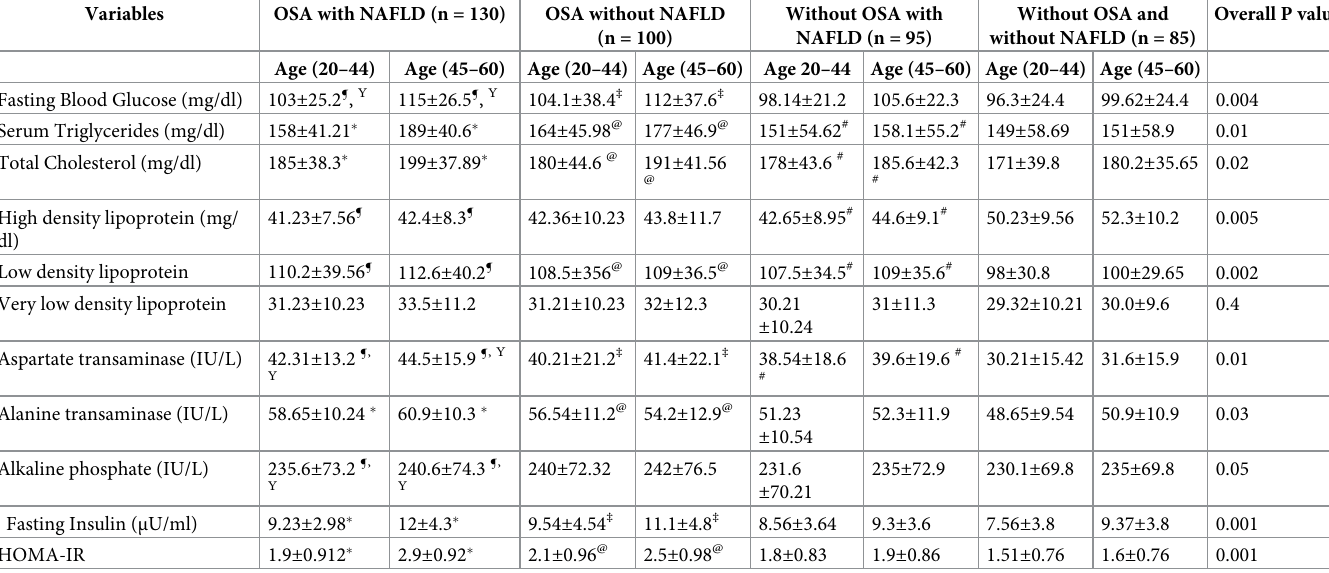
Table 3. Biochemical investigations. Variables